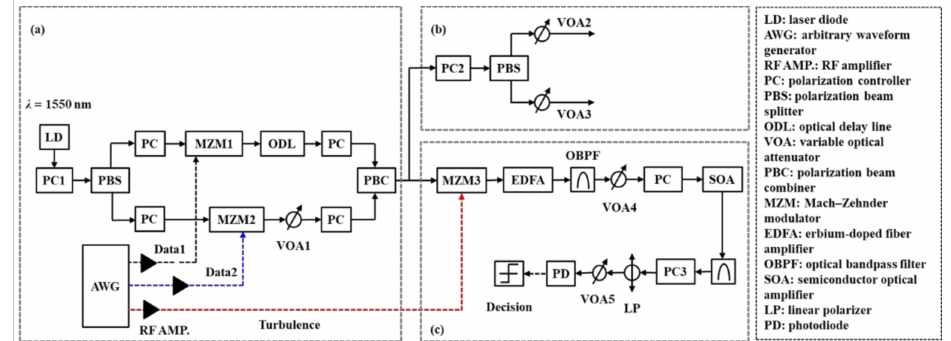
Figure 2. Experimental setup of the ( a ) MPS-OOK modulation, ( b ) SOP measurement, and ( c ) SOA-based MPS-OOK detection.